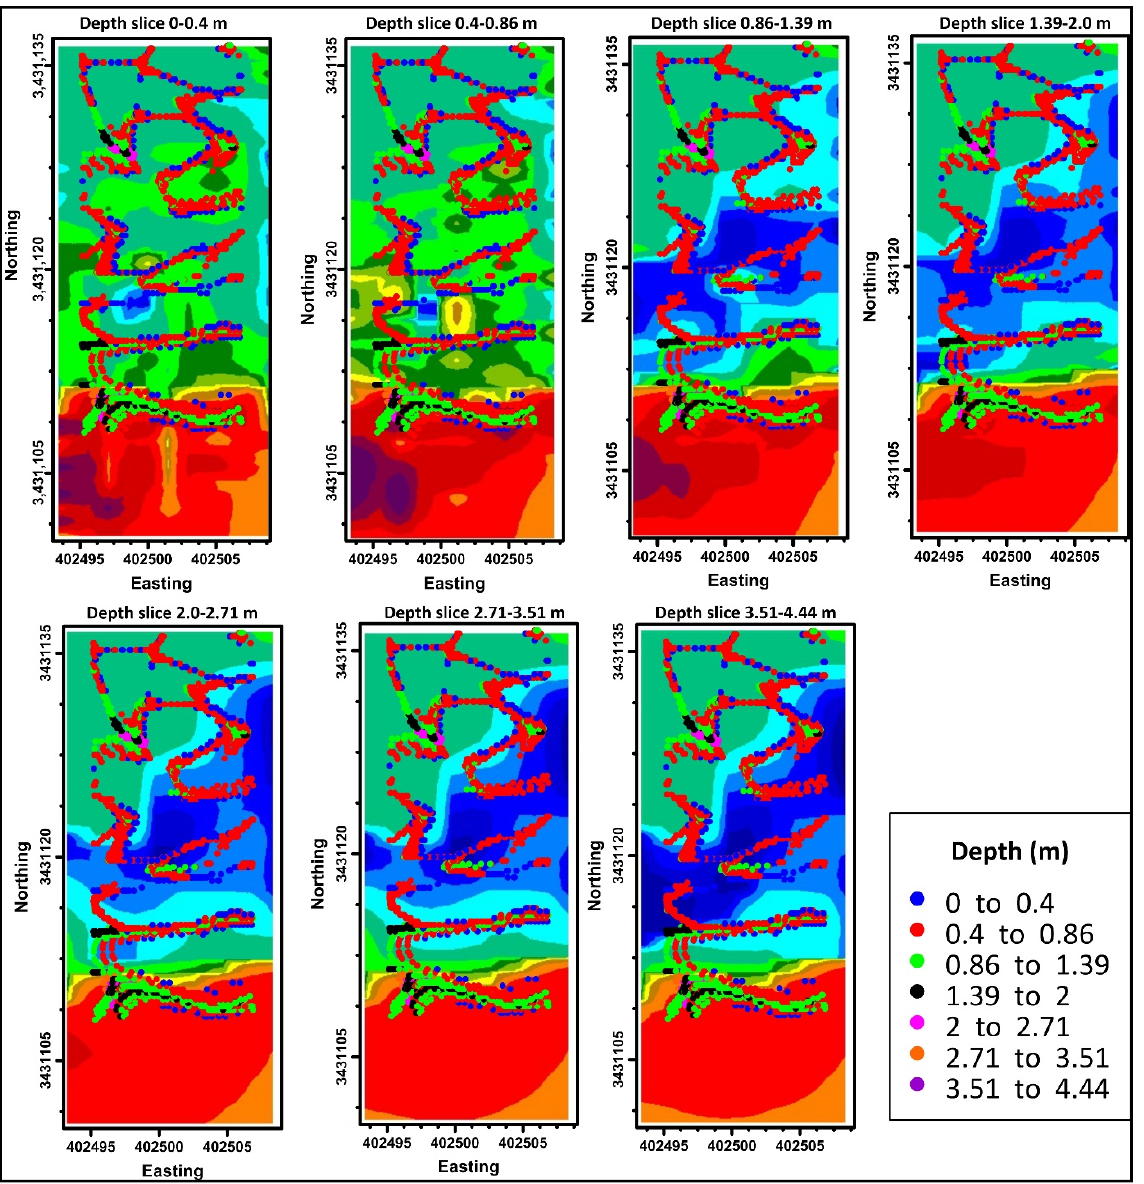
Figure 13. Combined representations of the Euler deconvolution solutions superimposed onto resistivity-depth slices.